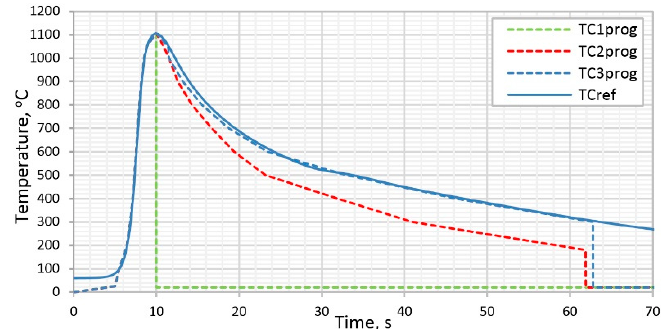
Figure 5. Program temperature cycles for the control Gleeble.